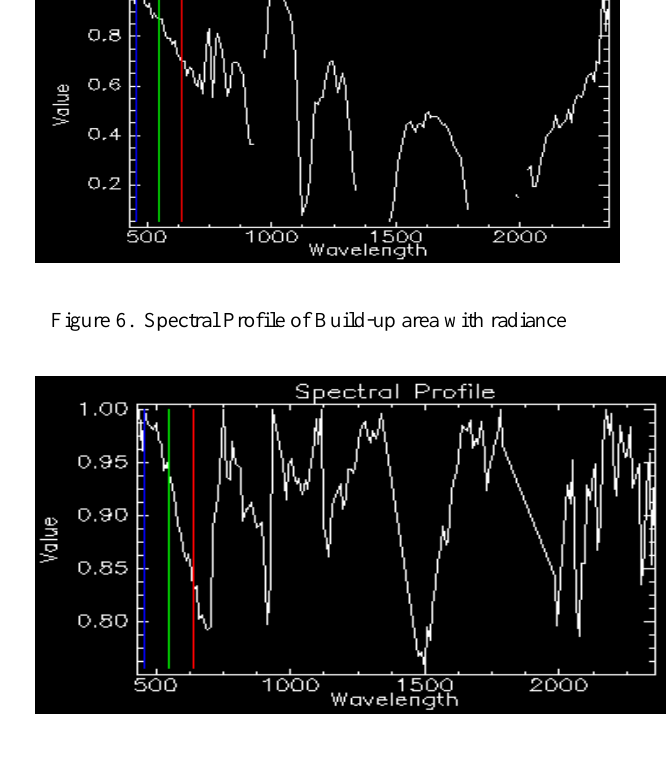
Figure 7. Spectral Profile of Builup area with reflectance